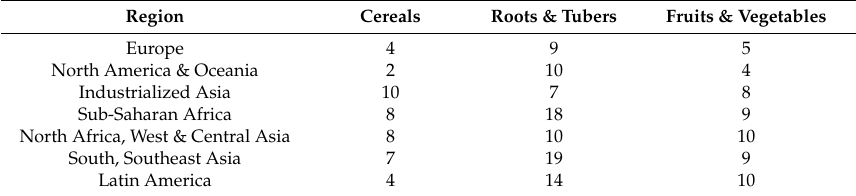
Table 1. Estimated post-harvest handling and storage losses in percentage [54]. Region Cereals Roots & Tubers Fruits & Vegetables Europe 4